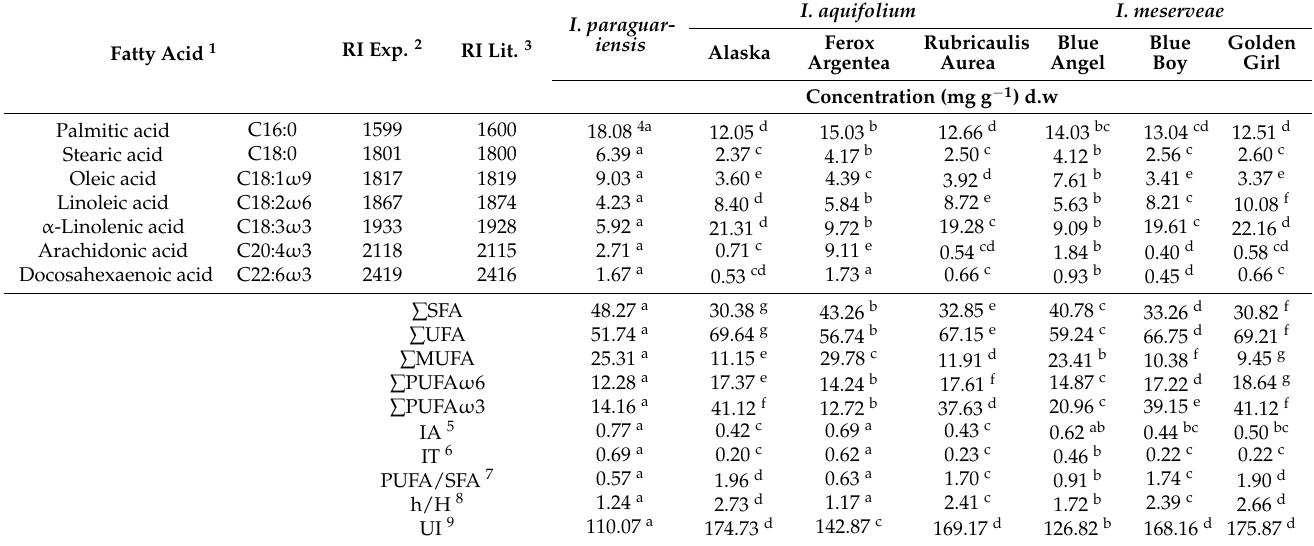
Table 3. Fatty acid profile and nutritional indices in leaves of I. paraguariensis and various varieties of I. aquifolium and I. meserveae